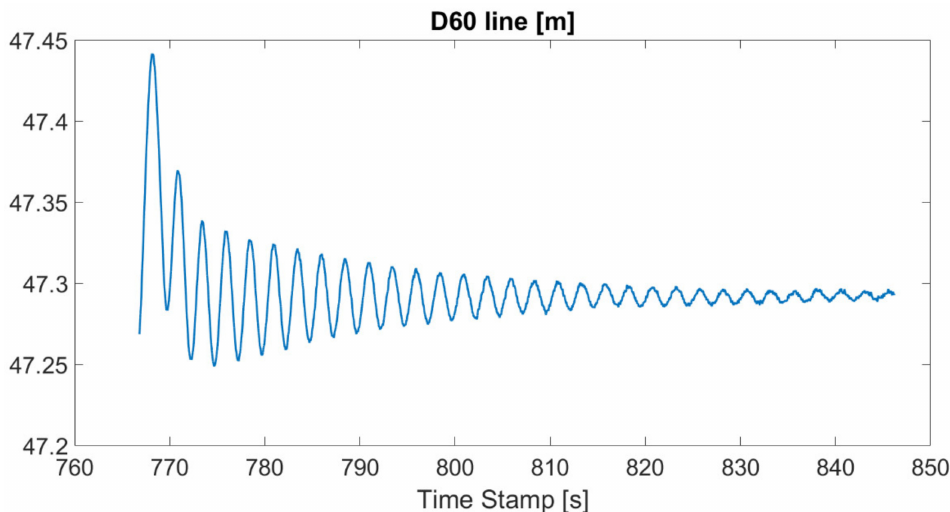
Figure 10. Ground distance D 60 line from TLS of a point 60 m high on the tower base during the deactivation of the turbine.